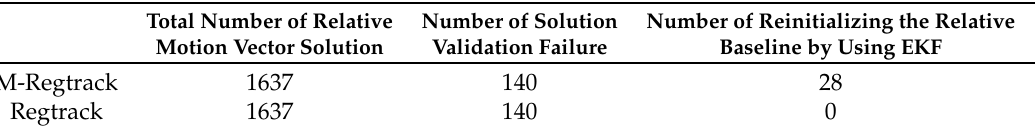
Table 3. The validation status of the relative motion vector solutions: kinematic experiment Section 3.2.3.